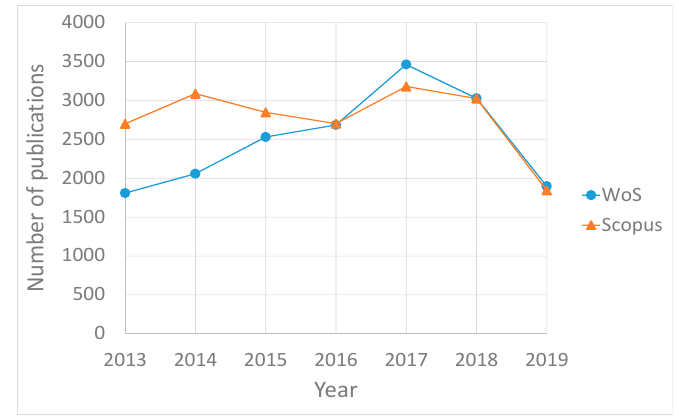
Figure 3. Trends in number of publications in the area of study in the period studied. Blue line: Web of Science, red line: Scopus.